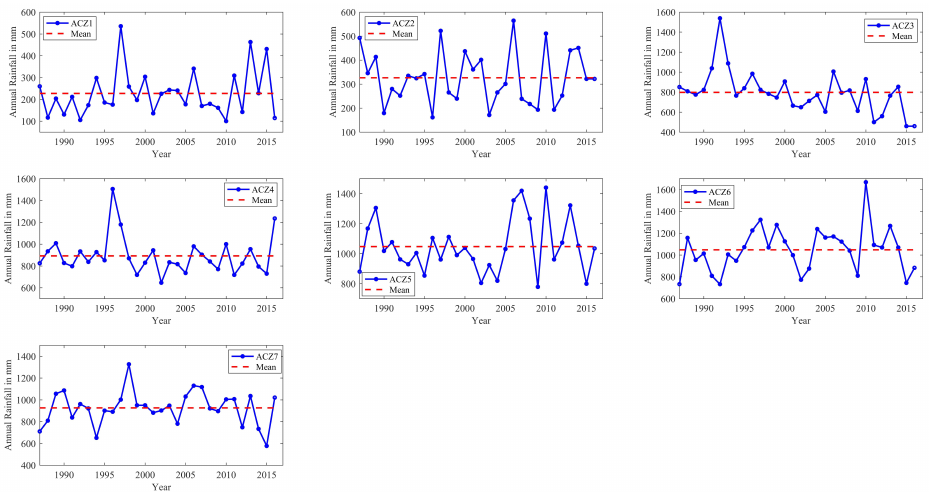
Figure 5. Annual rainfall pattern in agroclimatic zones from 1987 to